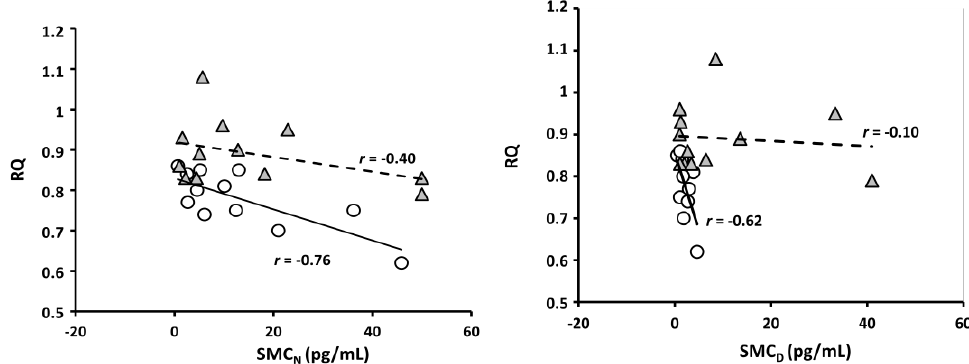
Figure 1. Salivary melatonin concentration (SMC) as related to respiratory quotient (RQ) (permission to be asked, Tapia et al., 2018) in n = 12. At the left, the relation between RQ and SMC at 12:00 PM (SMC D ) at sea level (white circles) and at high altitude (HA) (grey triangles). On the right side, the same relation at 12:00 AM (SMC N ), also at sea level and HA.